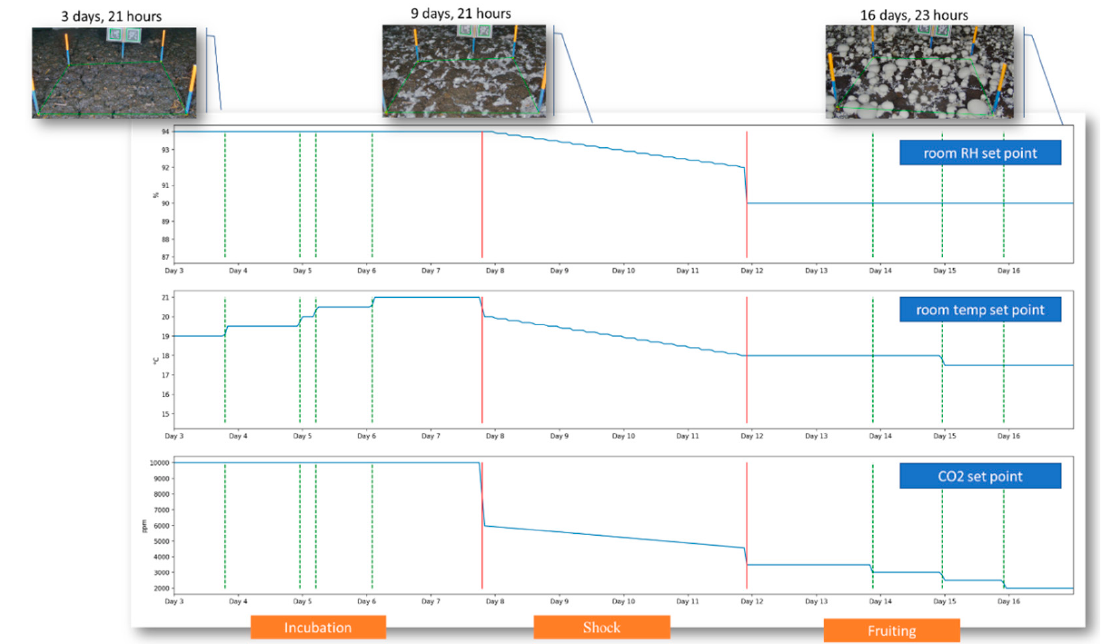
Figure 2. Example of parameters (relative humidity (RH), temperature, and CO 2 ) managed during the cultivation process. Red vertical lines represent termination moments of Incubation and Shock stages. Dashed green lines represent technologists’ actions to change the values of parameters. The photos provided on top visually represent the process on the 4th, 10th, 17th day of the process. The labels in the horizontal axis represent the number of days passed from the start of the cultivation.